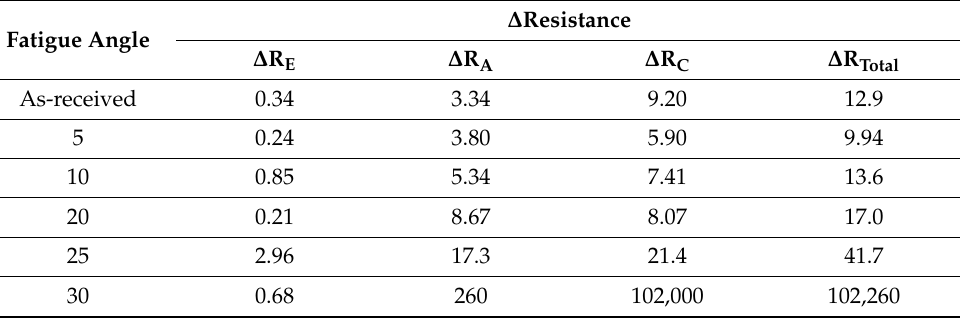
Table 3. Change values of the electrolyte resistance ( ∆ R E ), anode resistance ( ∆ R A ), and cathode resistance ( ∆ R C ) after the mechanical and cycling tests under different torsional test